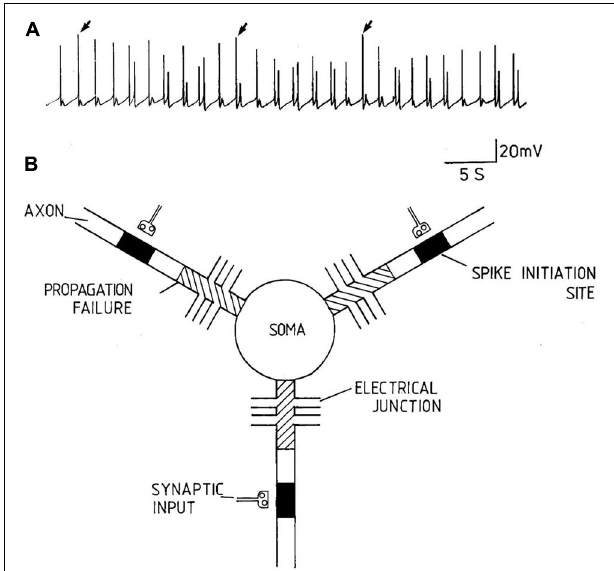
FIGURE 3 | An example of compartmentalization of axons from a multipolar pleural D group neuron of Lymnaea stagnalis . (A) Spontaneous discharges recorded from the soma of a multipolar pleural D group neuron. The discharge varies between subthreshold depolarisations of varying amplitude to large overshooting action potentials (from Winlow, 1989, with permission). (B) Diagrammatic model of pleural D group neurons. The filled boxes in the axons represent spike initiation sites and the cross hatching represents regions of propagation failure. Each radial axon is spontaneously active and can act to generate spikes independently of the others. The electrical synapses appear to keep the axons functionally compartmentalised from one another (Reproduced, with permission, from Haydon and Winlow,